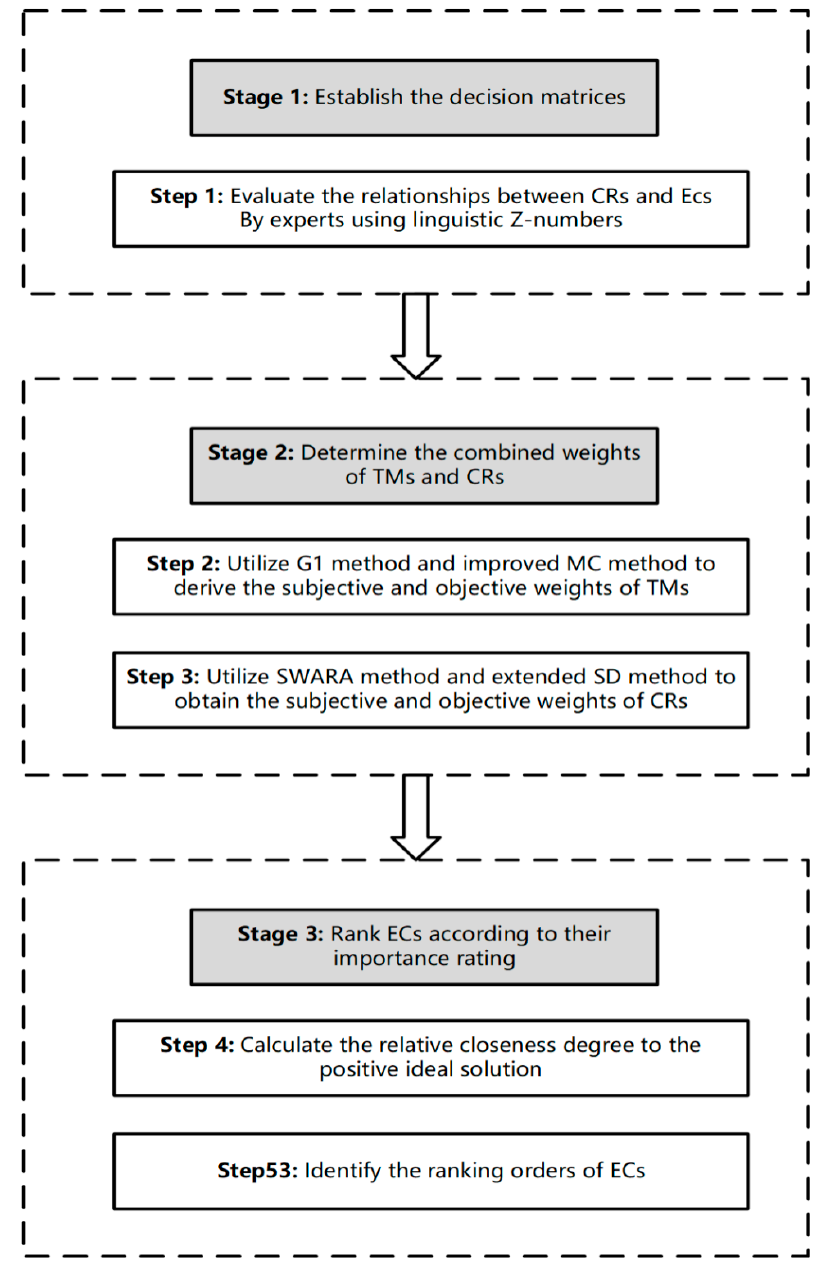
Figure 3. The conceptual framework of the proposed model for QFD.